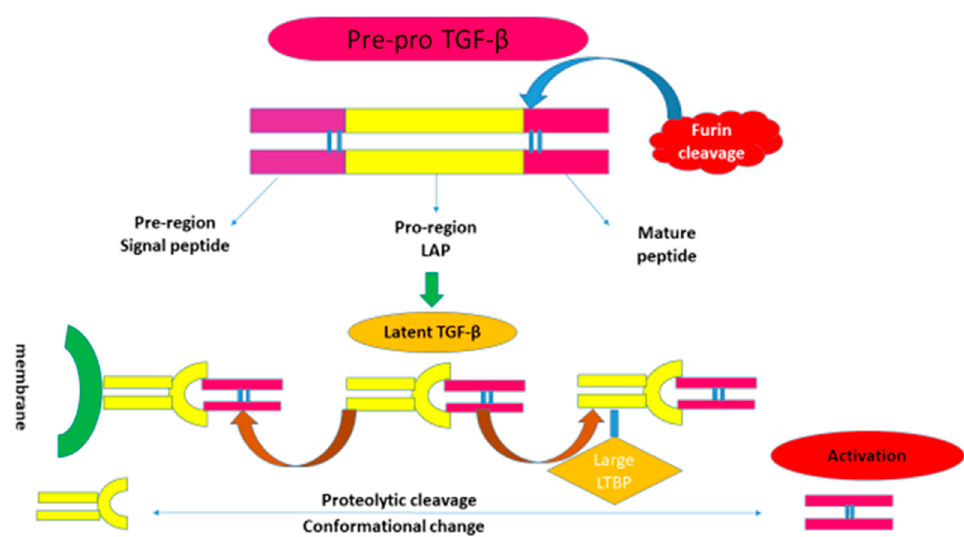
Figure 2. Schematic of the different forms of latent TGF- β . TGF- β : transforming growth factor-beta; LAP: latency-associated peptide. TGF- β is synthesized as an inactive form and cleaved by endopeptidase furin to generate a mature form which is still without biological activity. This is a literature review of the presence of latency-associated peptide (LAP) and latent TGF- β binding protein (LTBP). This large TGF- β associated complex is excreted into the extracellular matrix, cross-linked by tissue transglutaminase, and stored in the tissues in an inactive form. Once TGF- β releases from the latency-maintaining protein complex LAP/LTBP, it will display its powerful biological activity. The active form of TGF- β is a dimer stabilized by hydrophobic interactions and further strengthened by an inter-subunit disulfide bridge in most cases.